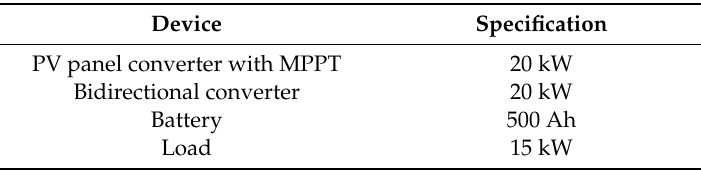
Figure 7. Test DC microgrid structure. Table 4. Microgrid Specifications.